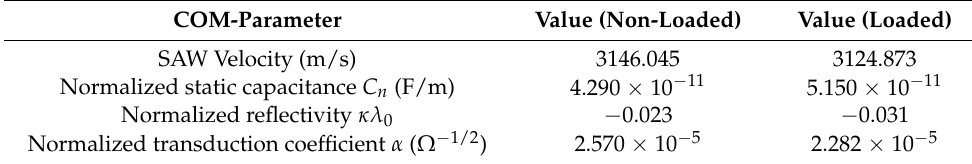
Figure 4. Schematic diagram ( a ) and mesh geometry ( b ) of the periodic model. Table 3. Extraction results of COM parameters before and after being loaded.